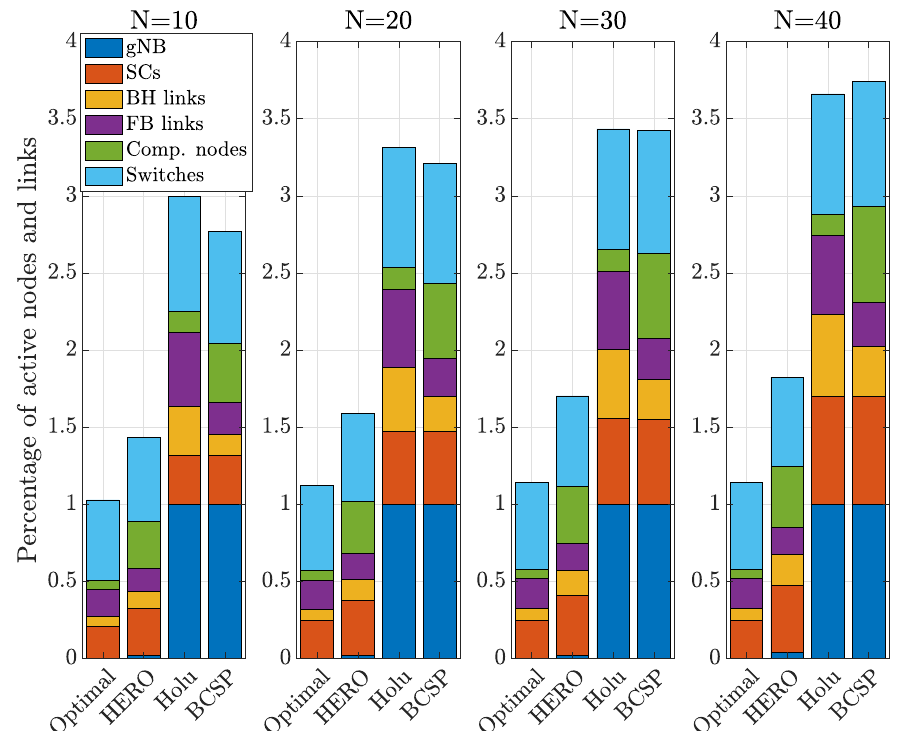
Figure 9. Percentage of active nodes and links of all algorithms for different numbers of UEs per gNB